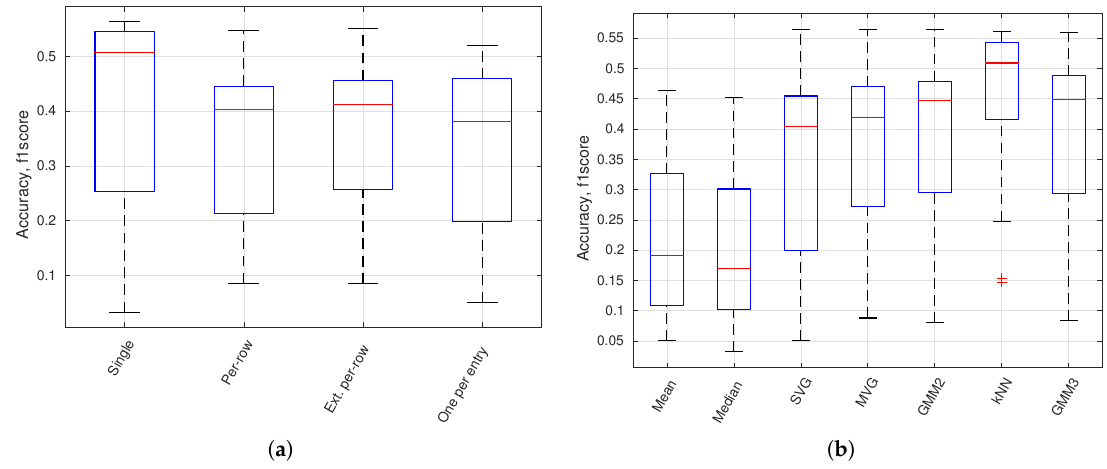
Figure 13. Accuracy for model geometries ( a ) and normality models ( b ). ( a ) Accuracy (f1 score) for all image model geometries; ( b ) accuracy (f1 score) for all normality model types.